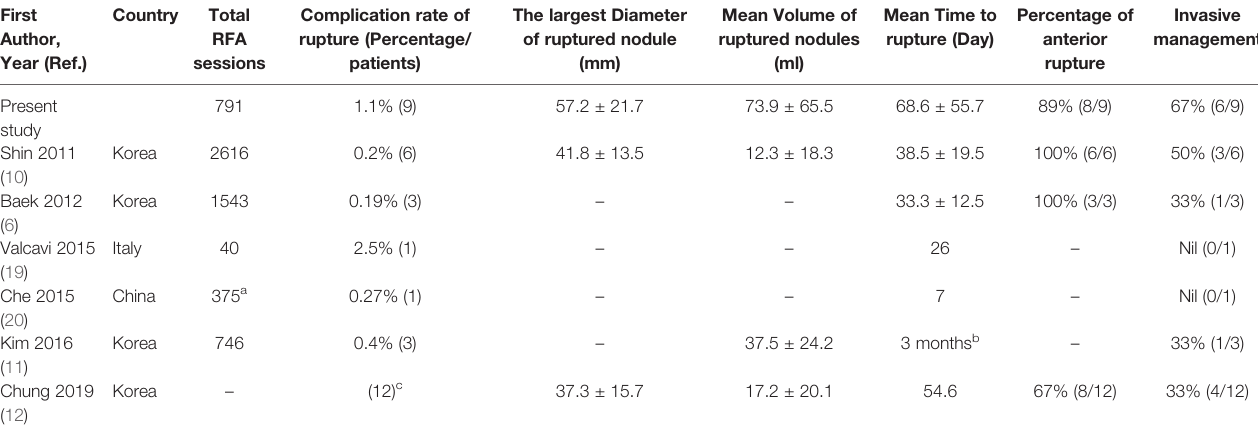
TABLE 3 | Literature review of goiter rupture after RFA for benign